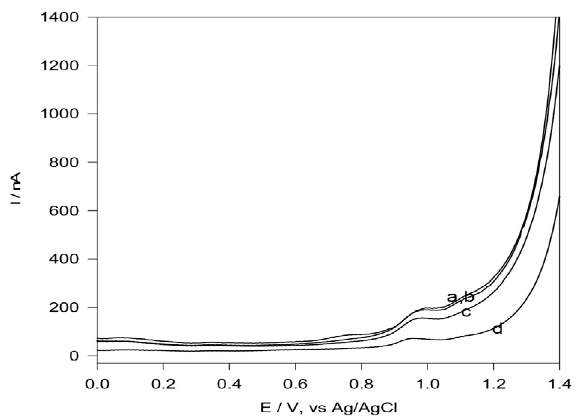
Figure 3A . Differential pulse voltammograms for 3.98 × 10 –6 mol/L chlorzoxazone in different media: a, 0.04 mol/L; b, 0.1 mol/L, c, 0.02